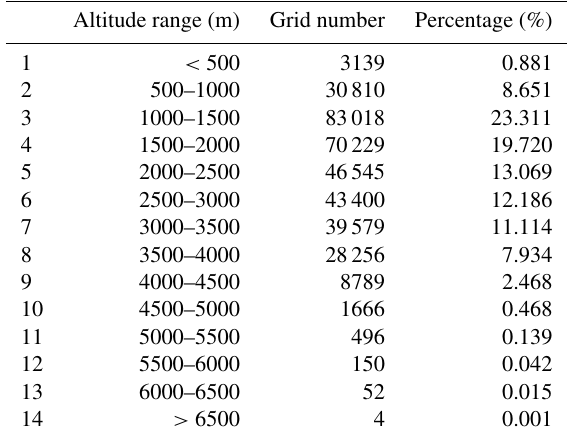
Table 1. Grid number and percentage for each altitude group over the